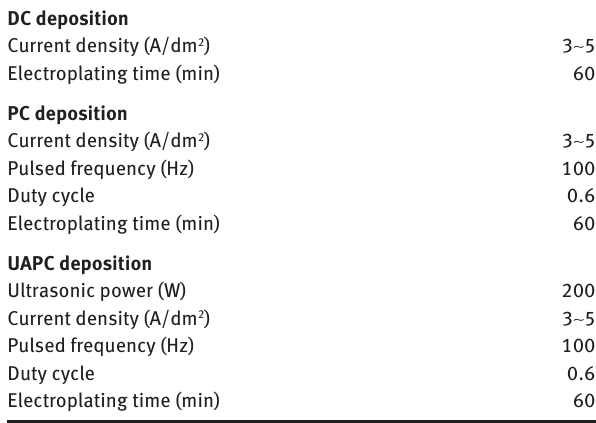
Table 1 Operating parameters for Ni-AlN thin film electrodeposition.